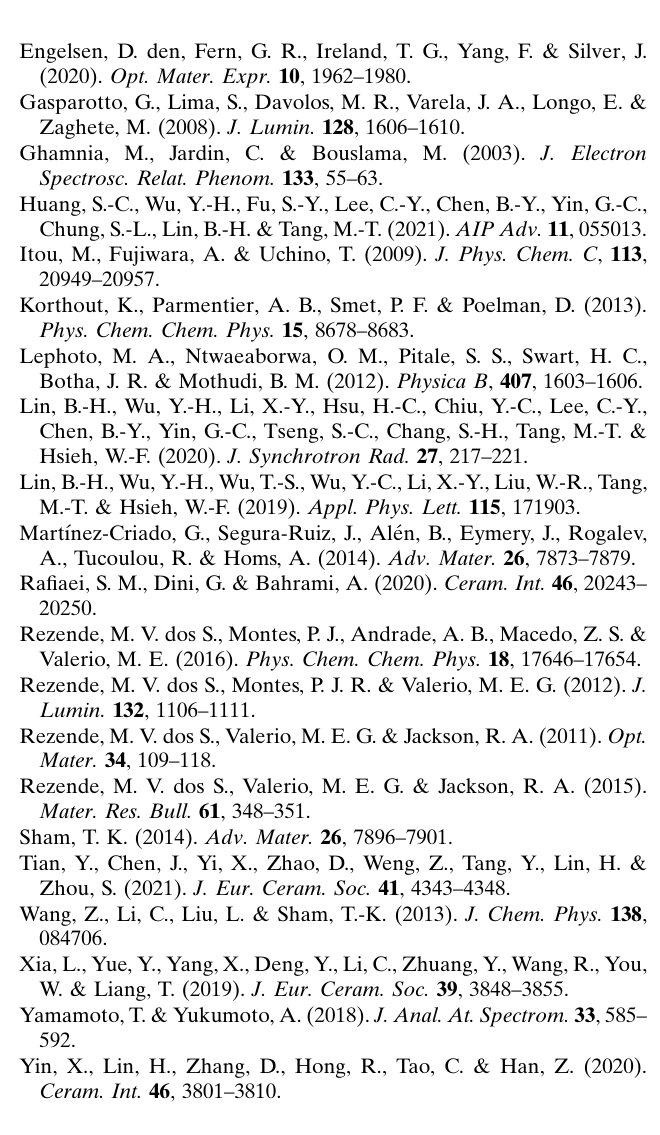
Figure 6 Rows ( a )–( d ) and ( e )–( h ) show the emission intensities of (cid:2) em = 390, 500, 588 and 698 nm as a function of Eu 2+ and Eu 3+ ions, respectively. A pixel-by- pixel analysis can be conducted to determine the overall correlation between the (cid:2) em = 390, 500, 588 and 698 nm and Eu 2+ and Eu 3+